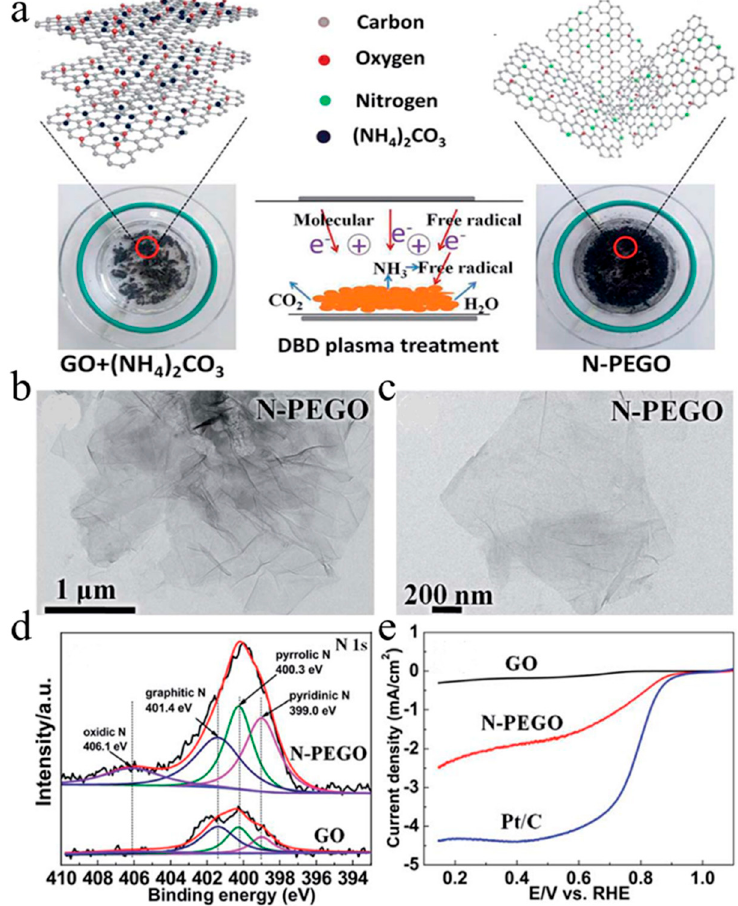
Figure 4. ( a ) the method of synthesizing N-PEGO; ( b , c ) TEM images of N-PEGO; ( d ) the N 1s spectrum of the samples; ( e ) LSV curves of GO, N-PEGO and 20 wt% Pt/C. Reproduced with permission from [58]; Copyright Royal Society of Chemistry, 2018.